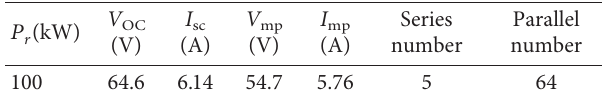
Table 3: Photovoltaic parameter.